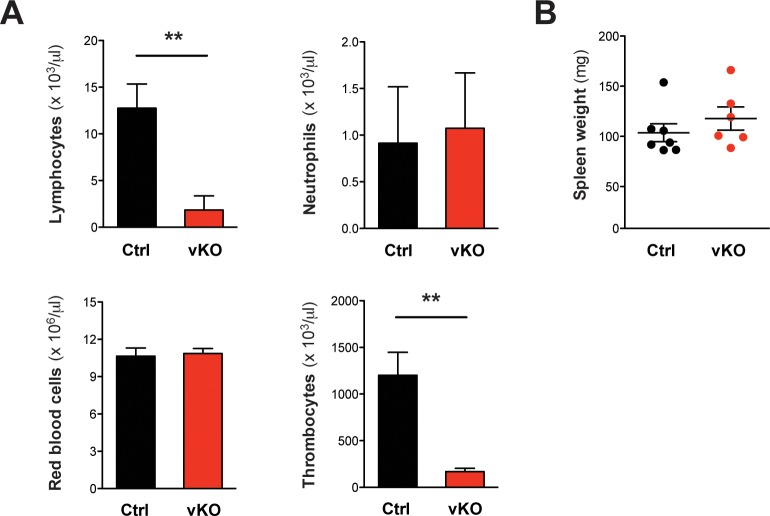
Blood count analysis and spleen weights in VC/+ transplanted mice.(A) Peripheral blood counts of transplanted mice at the final analysis date 16 weeks after TX (Ctrl n = 6, vKO n = 6). Both lymphocyte and thrombocyte counts were severely diminished in vKO transplanted mice (p**=0.002). (B) Spleen weights were comparable between vKO transplanted mice (n = 7) and controls (n = 6). The graphs in (A) depict the mean ± SD, in (B) the mean ± SEM is shown.